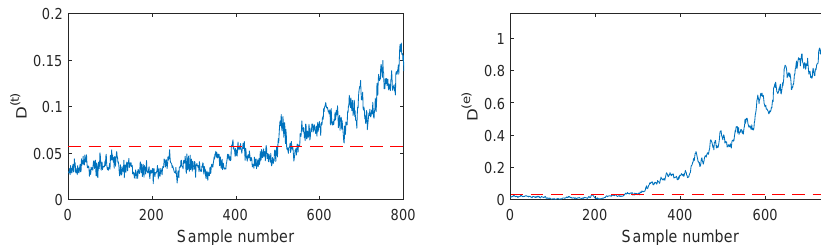
Figure 9. CAE-SVDD monitoring charts for fault F2.